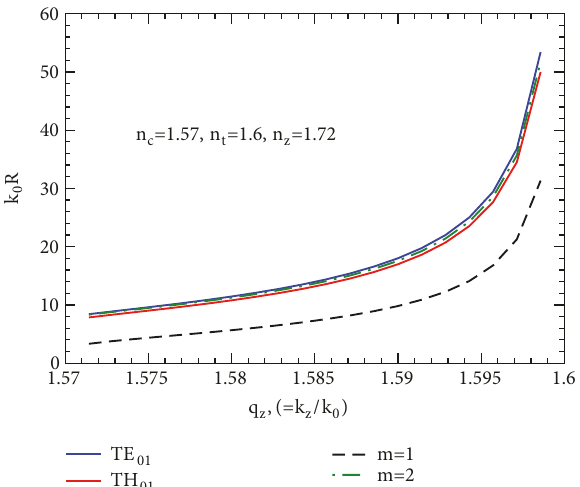
Figure 5: Dimensionless parameter 𝑘 0 𝑅 ≡ 𝜔𝑅/𝑐 as a function of 𝑞 𝑧 = 𝑘 𝑧 /𝑘 0 for the waves with 0 ≤ 𝑚 ≤ 2 at 𝑛 𝑧 = 1.72 > 𝑛 𝑡 = 1.6 ≈ 𝑛 𝑐 .